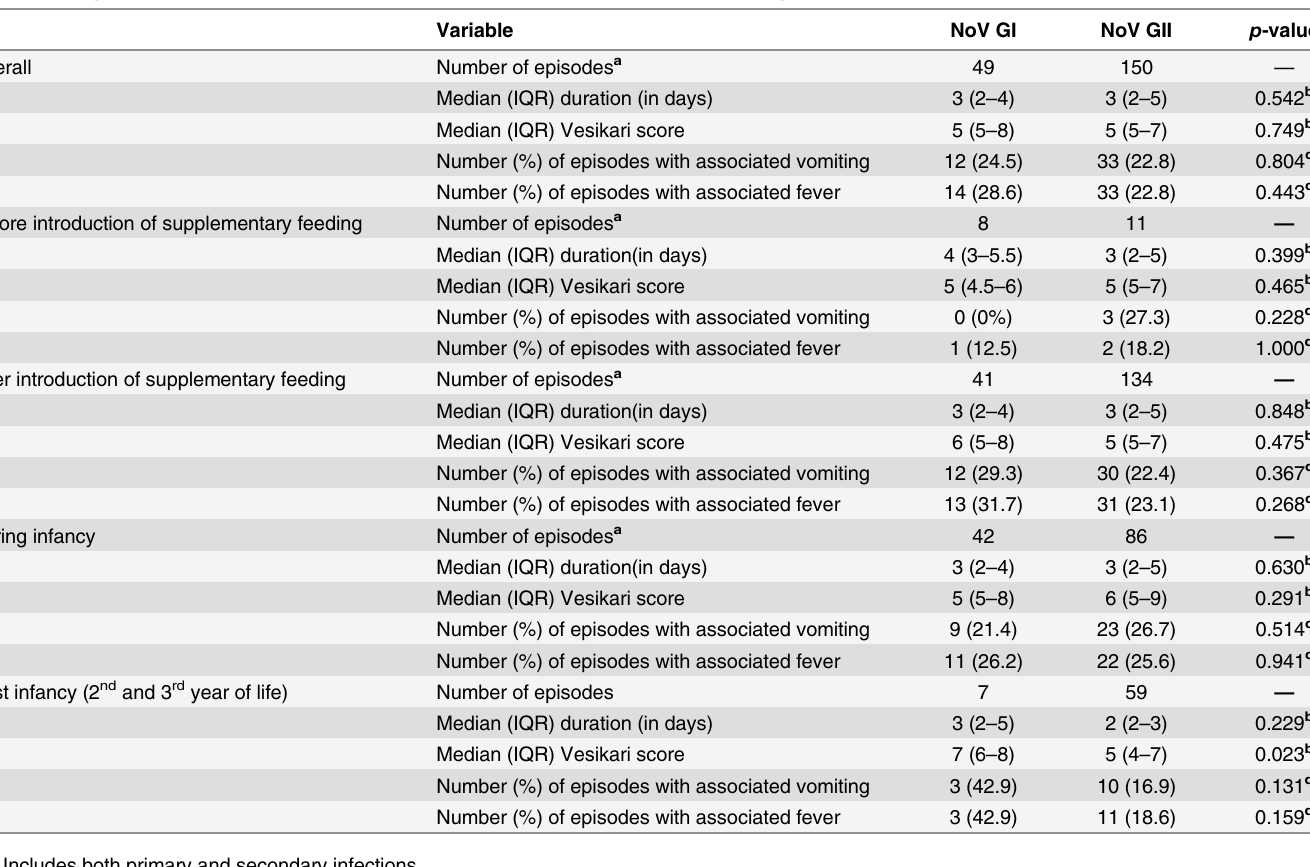
Table 1. Comparison of clinical characteristics between norovirus GI and GII diarrheal